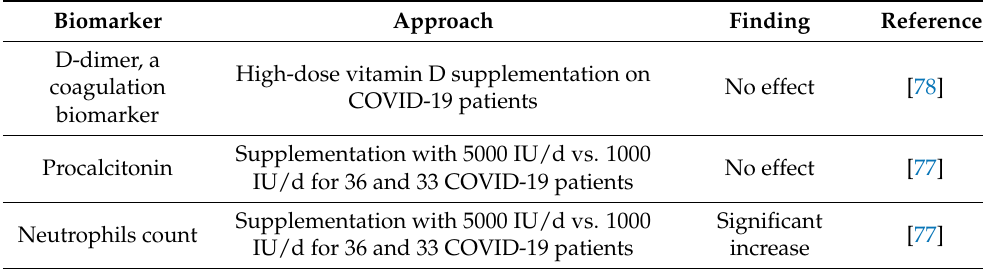
Table 2. Evidence that vitamin D reduces concentrations of biomarkers associated with long COVID. Biomarker Approach Finding